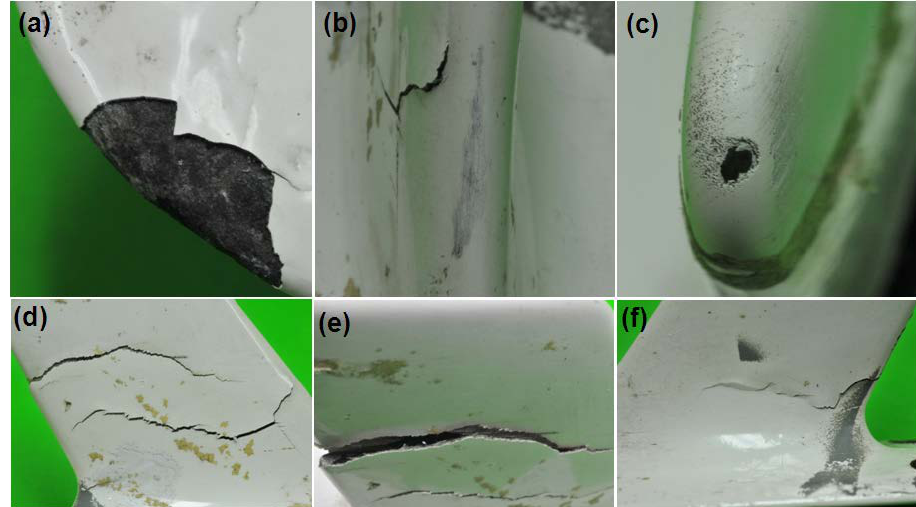
Figure 4: (a), (b) and (c) are corresponding to enlarged views of the A, B and C locations (Fig.3) displaying impact marks; (d), (e) and (f) are enlarged views of the antenna exhibiting multiple cracks at middle of the fin.